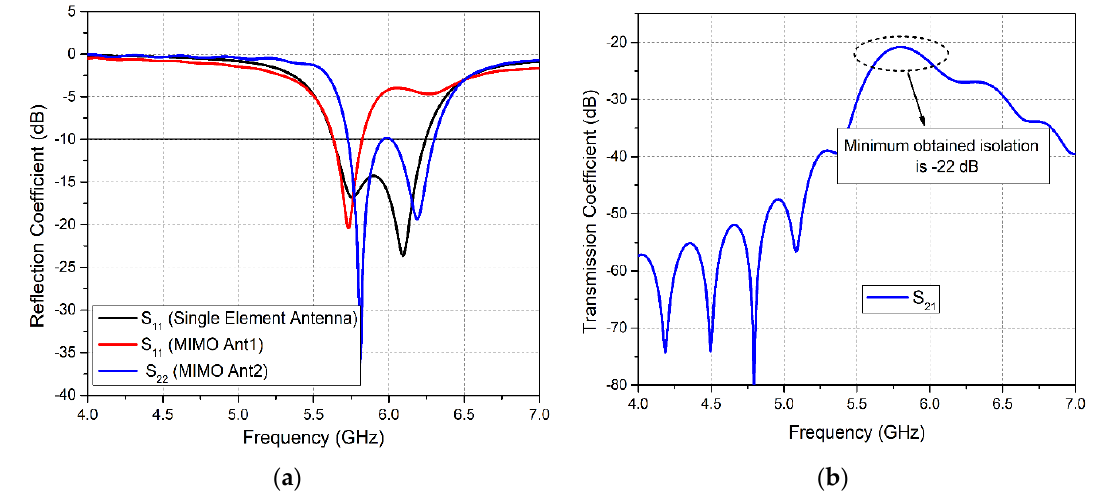
Figure 3. Simulated S-parameter Curves for LTE Antenna: ( a ) Reflection Coefficient Curves; ( b ) Transmission Coefficient Curve.